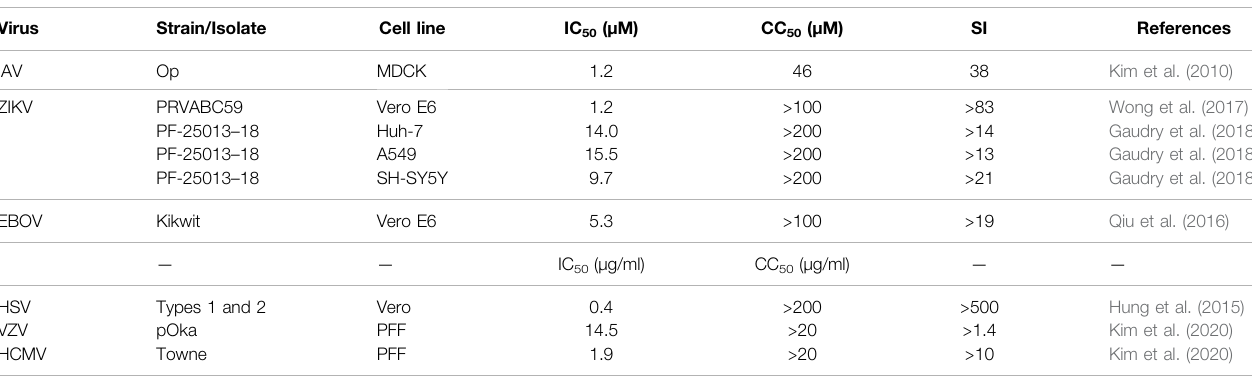
TABLE 2 | Isoquercetin antiviral ef fi ciency and selectivity. Virus